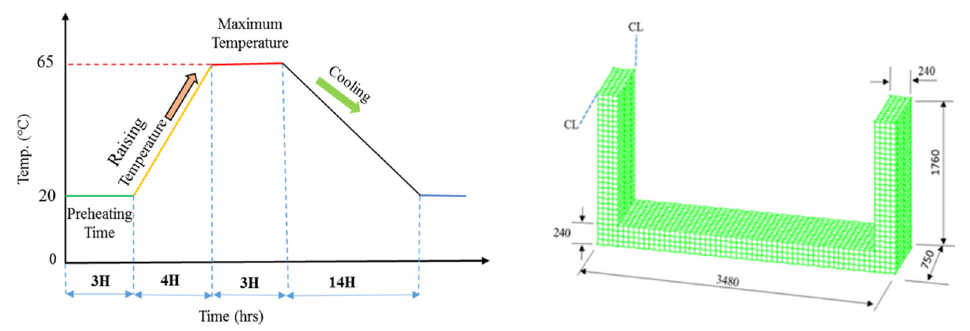
Figure 10. Ambient temperature profile for 3D FEM analysis ( Left ) and the quarter section of the precast concrete model ( right ).